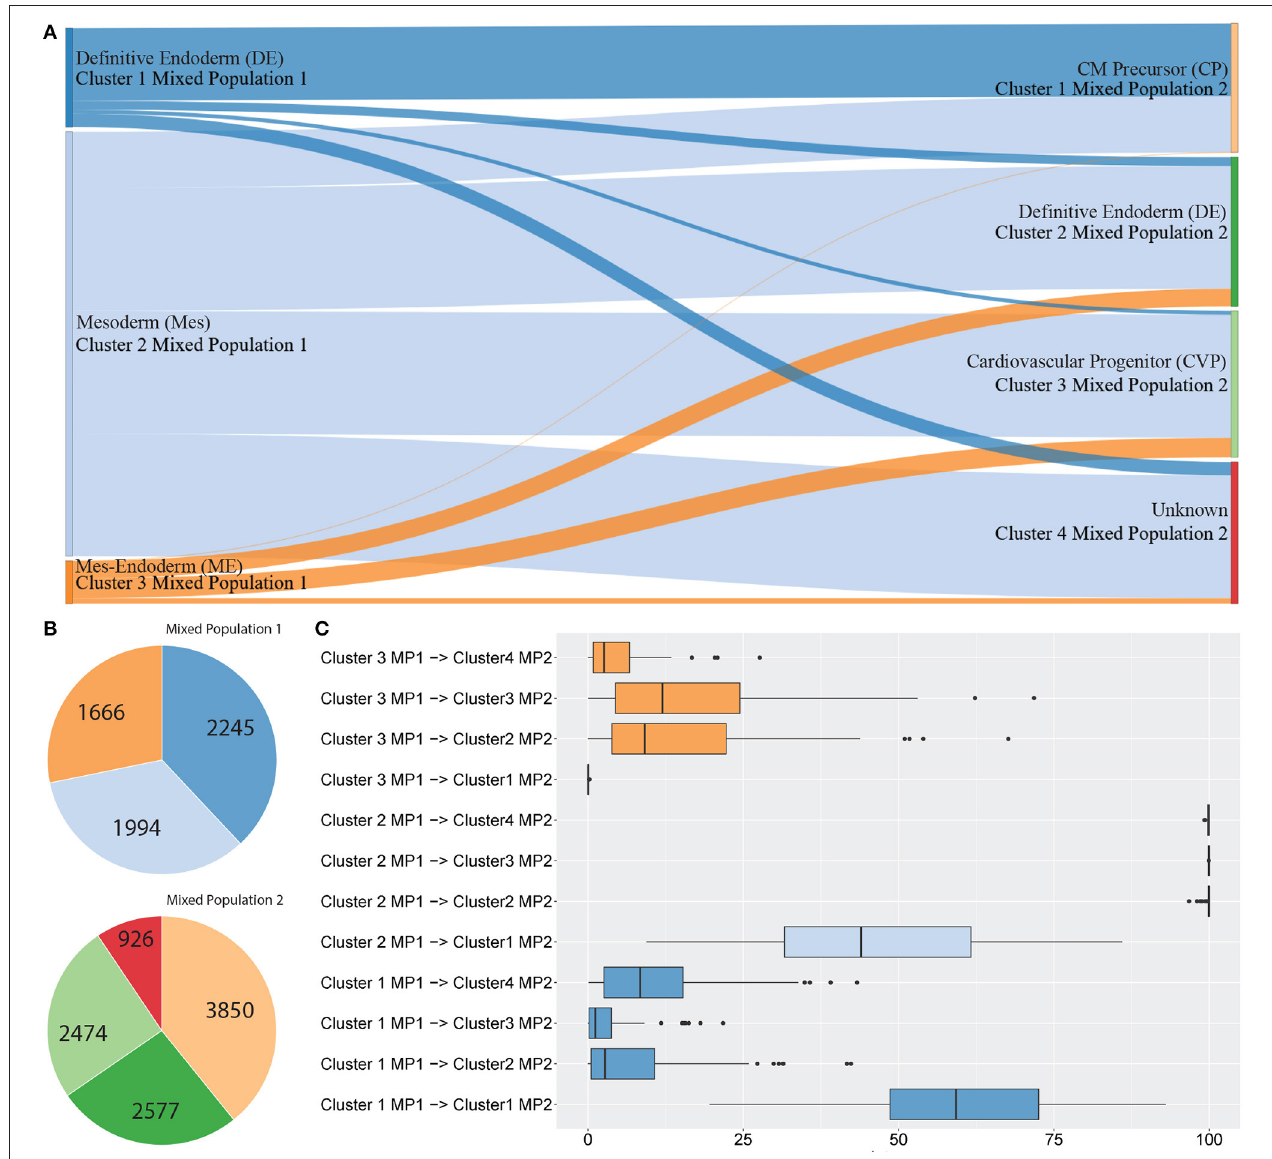
FIGURE 3 | scGPS trajectory analysis. scGPS trajectory analysis can perform transitioning prediction between two populations (this Figure 3 ) or within a heterogenous population ( Figure 4 ). In (A) edges show pairwise connections between two clusters, where each node (a vertical bar) represents a cluster, and the edge width is proportional to the transitioning score from one cluster to another. MP represents a mixed population (i.e., the total dataset for one mixed sample, containing multiple clusters). Each coloured bar represents one subpopulation (a cluster). (A) Transitioning between three subpopulations in the mixed population 1 (MP1) to four subpopulations in the mixed population 2 (MP2). (B) The number of cells in each cluster shown in (A) . (C) Bootstrapping results displaying the summary scores from one hundred bootstraps used for the same data shown in (A)